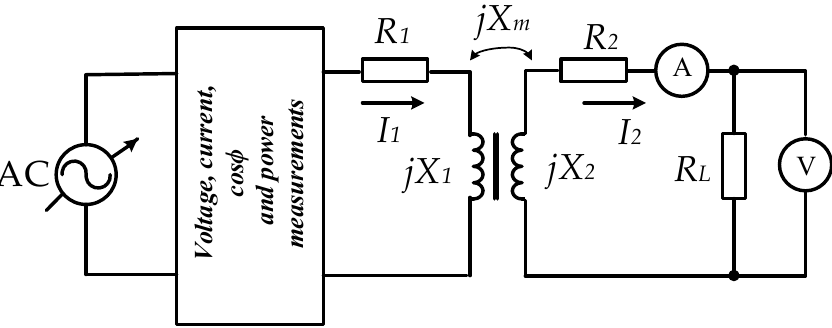
Figure 2. Schematic representation of principle to create two perpendicular coils ( a ) internal winding covered with ferromagnetic ribbon, ( b ) external coil on the ferromagnetic core.